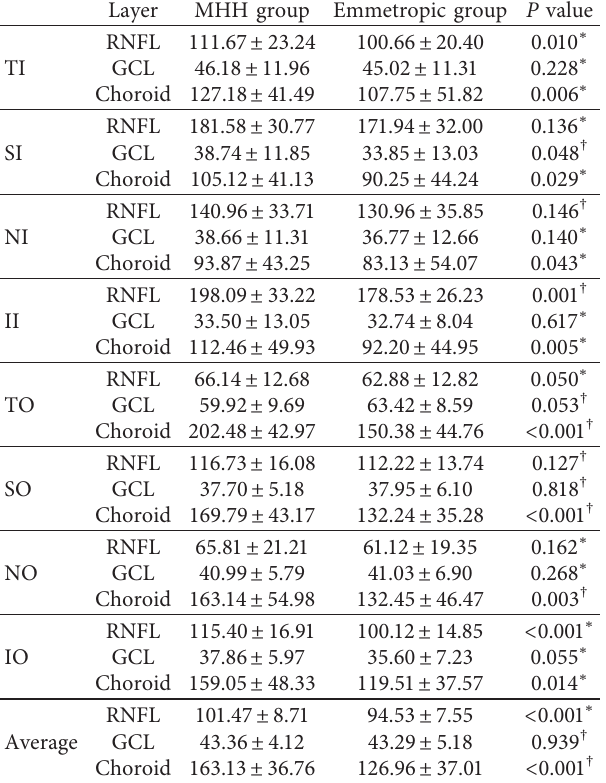
Table 3: Comparison of the thickness of the RNFL, GCL, and choroid in the macula between the MHH and emmetropic groups.